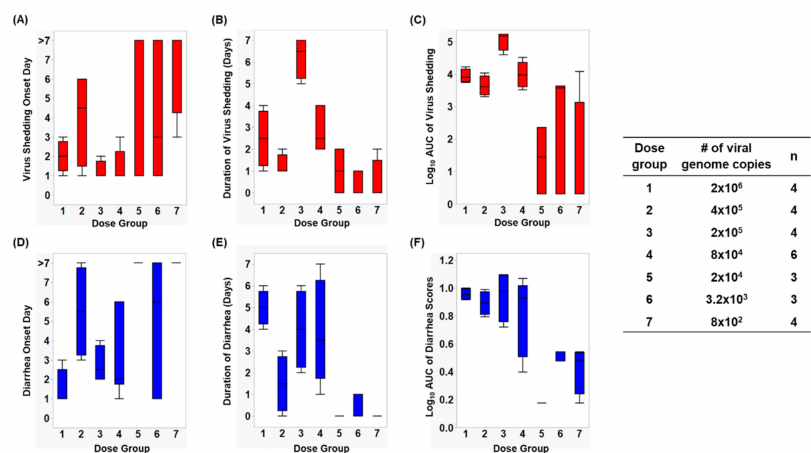
Figure 1. Box and whisker plots showing ( A ) virus shedding onset day, ( B ) duration of virus shedding, ( C ) log 10 AUC of virus shedding, ( D ) diarrhea onset day, ( E ) duration of diarrhea, and ( F ) log 10 cumulative diarrhea scores, among each dose group. The maximum and minimum values are denoted by the whisker and the boundaries of each box represent the quartiles with the mean indicated by a black